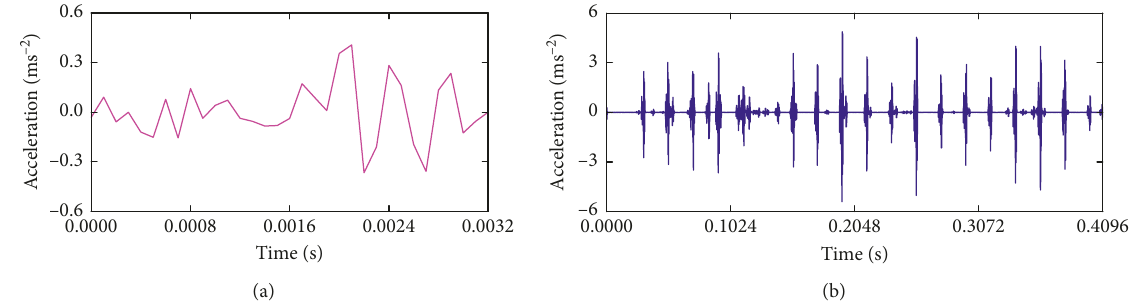
Figure 12: Extracted IRS: (a) learned impulse response; (b) extracted